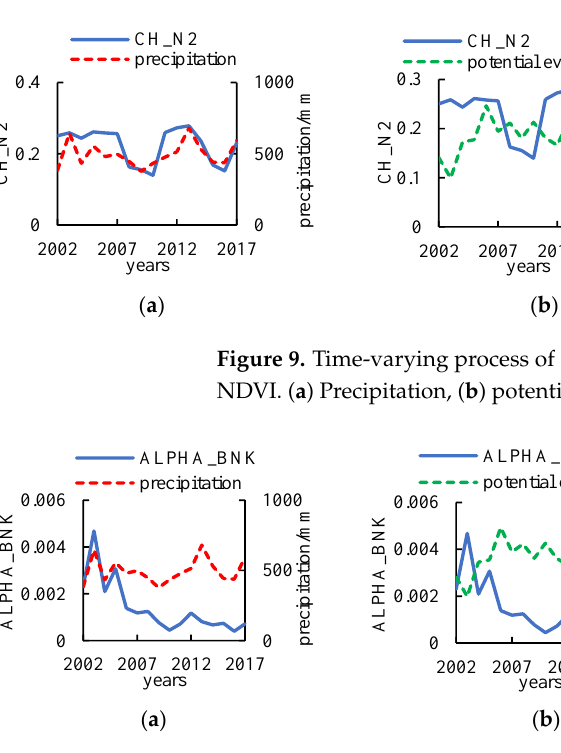
Figure 8. Time-varying process of ESCO to basin precipitation, potential evapotranspiration and